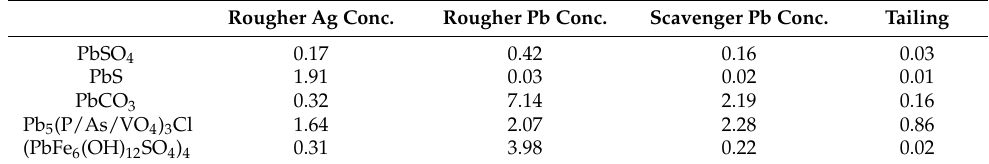
Table A3. The grade of Pb